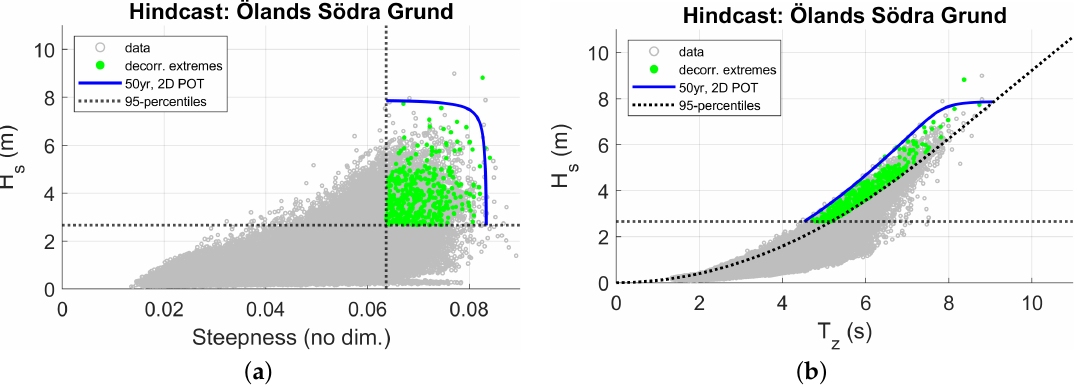
Figure 8. The 2D Peaks-Over-Threshold method. In subfigure ( a ), the data are shown in the ( s , H s ) -plane and the 95- percentiles are drawn. The 50-year return level curve is shown in blue. In subfigure ( b ), the data has been transformed back to the ( T z , H s )